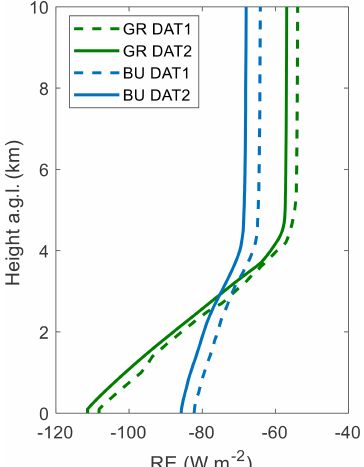
Figure 6. Profiles of the radiative efficiency (RE) obtained using CALIPSO (DAT1) and the ground-based EARLINET lidar (DAT2) extinction profiles on 4 April 2011 above Granada (GR) and on 7 July 2012 above Bucharest